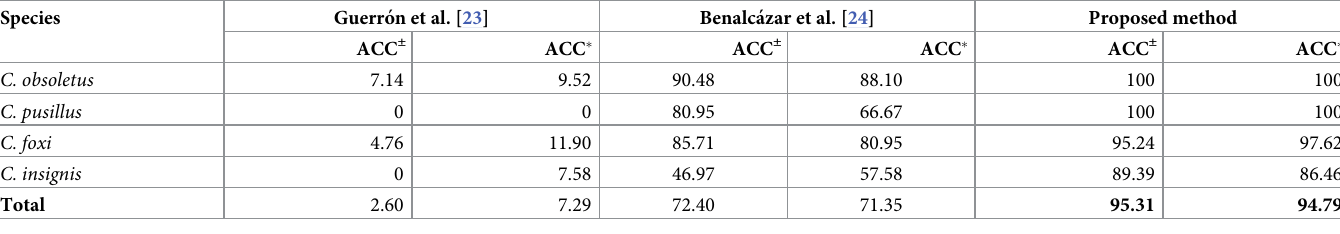
Table 5. Wings and particles ACC-based segmentation performance for the four species.